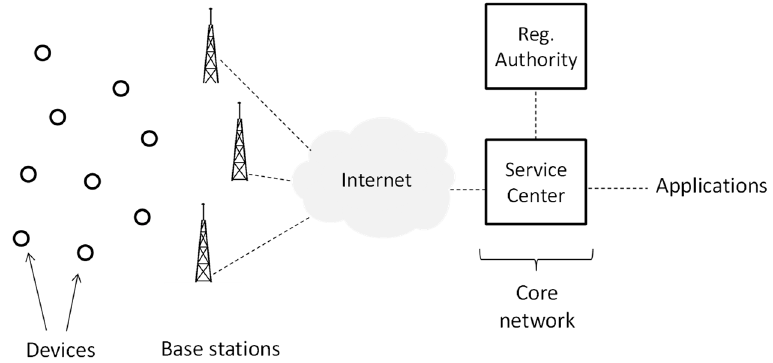
Figure 1. Sigfox network architecture [3].